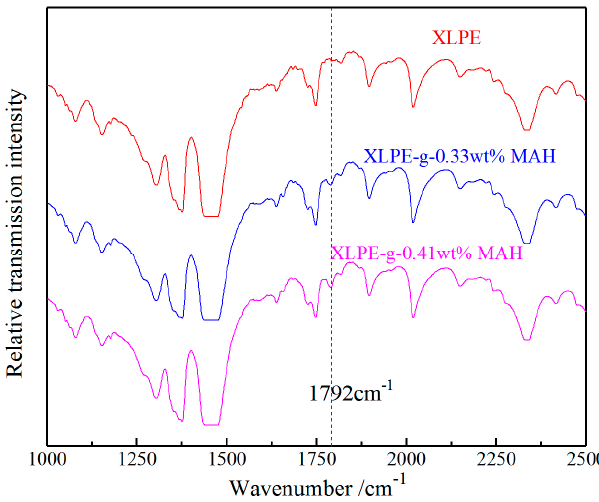
Figure 1. FT-IR transmission spectra of the pure XLPE and the XLPE-g-MAH with 0.33 wt% and 0.41 wt% grafting concentrations.